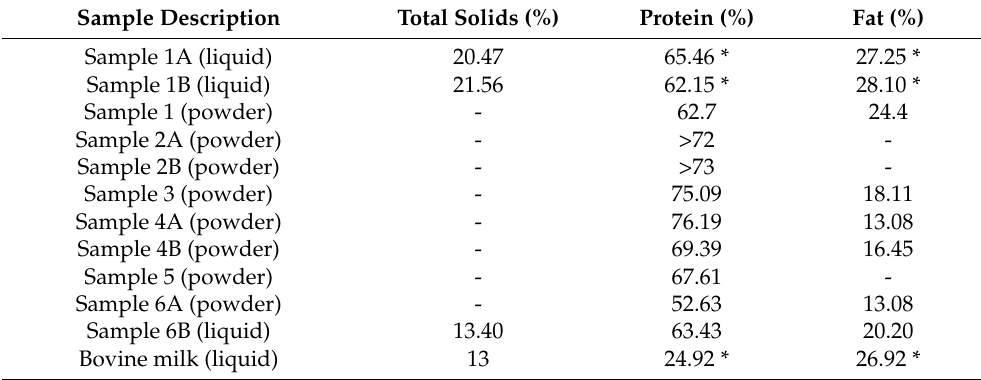
Table 1. Comparison between %solids, %protein, and %fat of the fat globule population measured from all WPPC